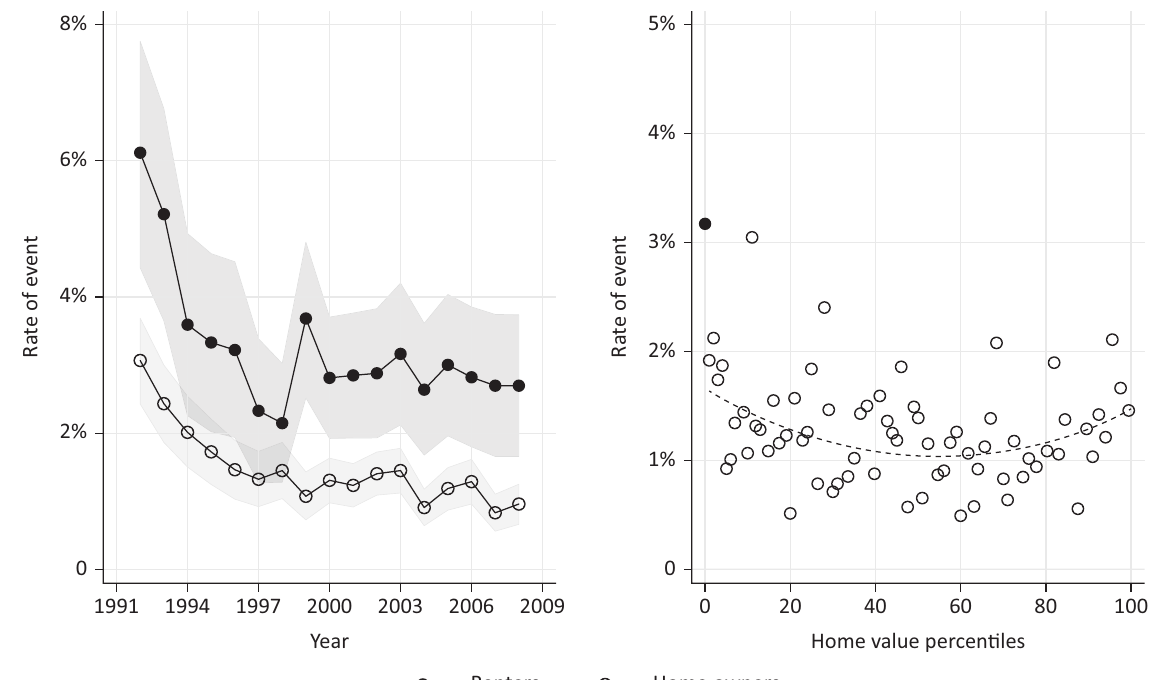
Figure 1. Risk of job loss: Renters vs. homeowners and across the distribution of home value. Notes: The first graph shows the rate of job loss across the observation period and how it varies between renters and owners; the second graph shows how the rate of job loss among homeowners across the distribution of home value in the pooled data; quantiles are defined based on the gross home value of primary residency in the year before the job loss; the estimates of the first graph show grouped averages across years, while the grey areas represent 95% confidence intervals of the point estimate; the second graph shows estimates from pooled data based on binned scatters (using 100 bins) and quadratic fit, calculated using bin‐ scatterplot command in Stata (see Stepner, 2013); for definitions of outcomes see Section